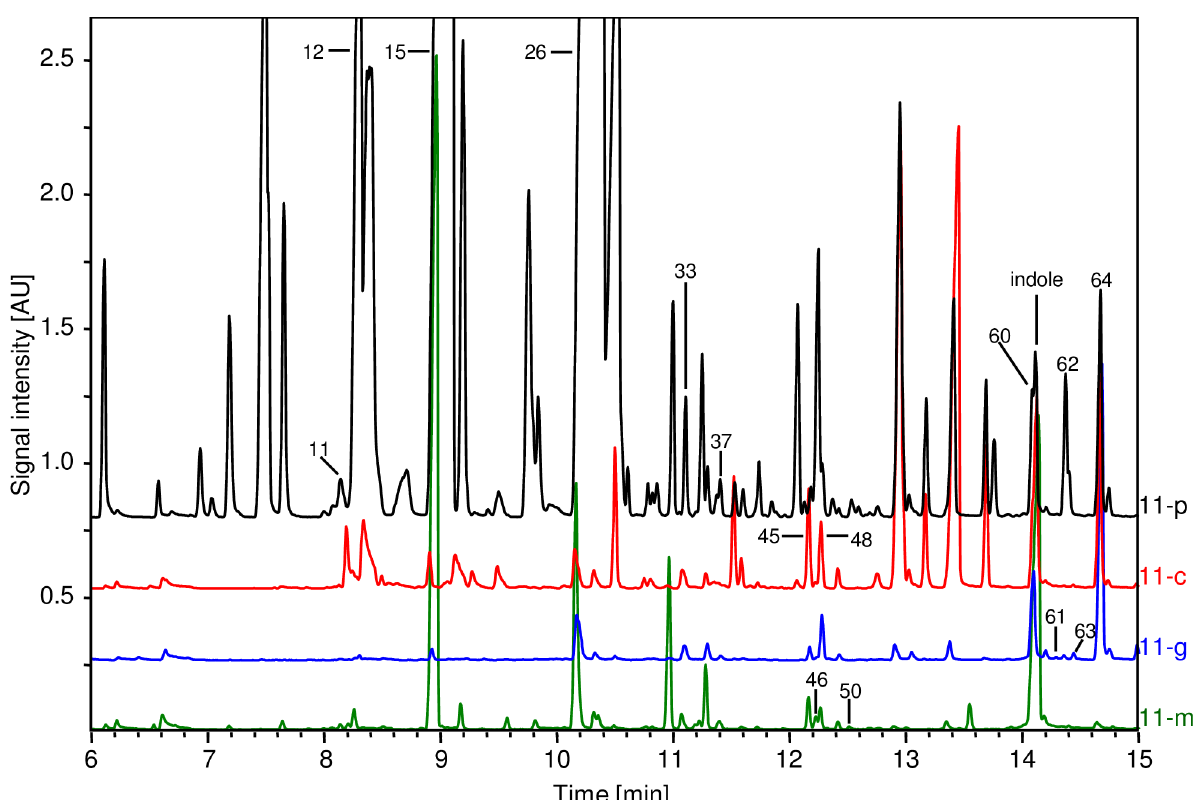
Fig 2. Total ion chromatograms of HS-SPME-GCMS analyses of four production strains expressing four different C11-TSs. The peaks of all identified and mentioned compounds are labeled. Compound names are listed in Table 3.